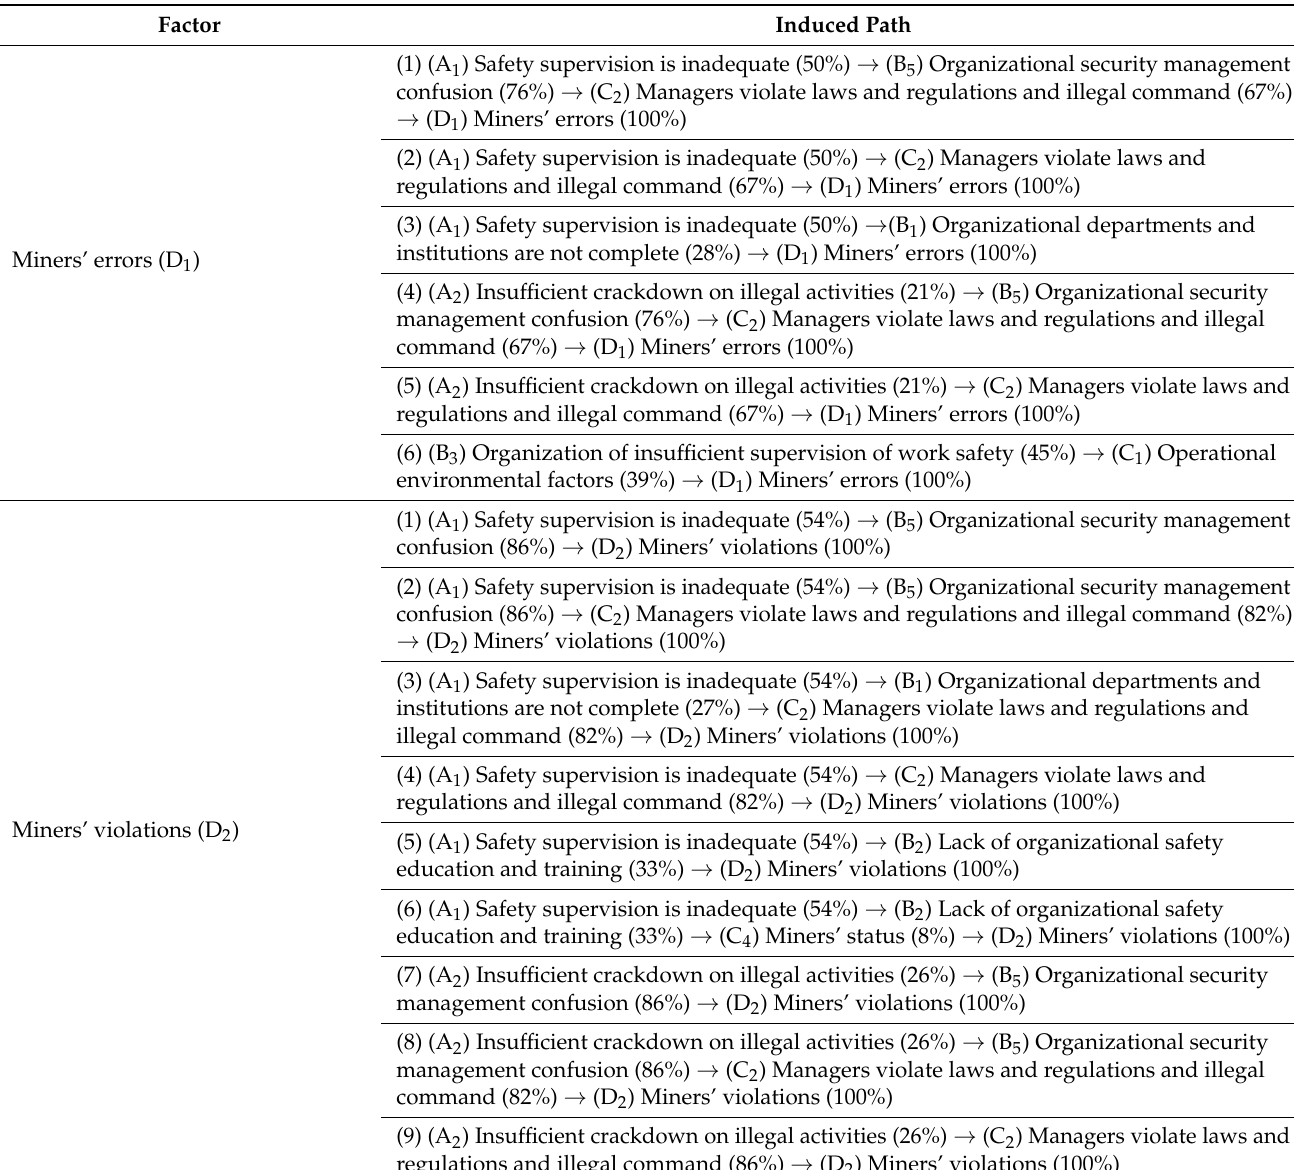
Table 6. Summary of unsafe acts risk paths for